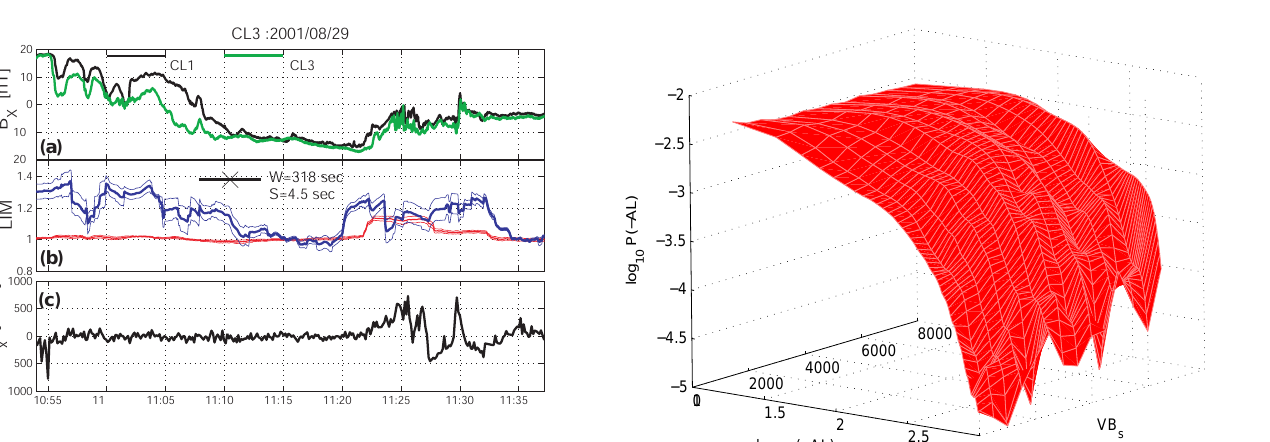
Fig. 47. The magnetic field component B x measured by Cluster 1 and 3 spacecraft on 29 August 2001 and the local intermittence mea- sure (LIM) from C3. The current sheet was bifurcated in structure and was subject to flapping between 10:55 and 11:05UT (Runov et al., 2003b). The B x components at C1 and C3 (panel a ) have similar variations but at different levels. The LIM values for the small-scale (red line) and large-scale (blue) variations differ signif- icantly during the current sheet flapping and bifurcation, indicating weak cross-scale coupling or dominantly coherent features. How- ever, the two measures are close when B x is quiet or is accompanied by flow bursts, as shown by proton data in panel (c) . The latter in- dicates turbulence, with the expected strong cross-scale coupling. (From V¨or¨os et al., 2003).